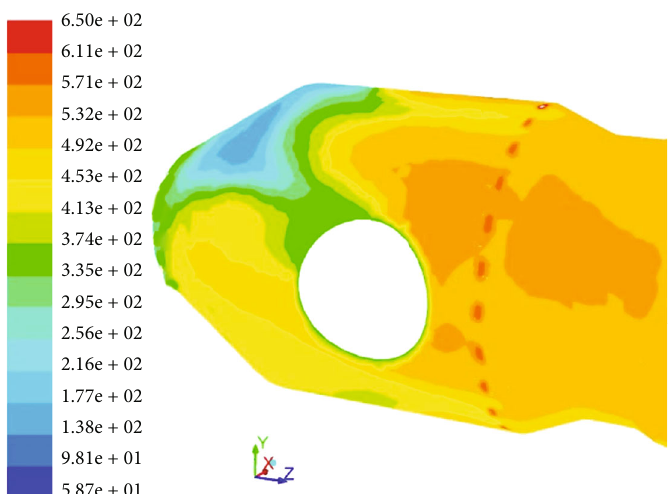
Figure 9: Temperature pro fi le in equidistant plain on 1.5 inch from engine surface.